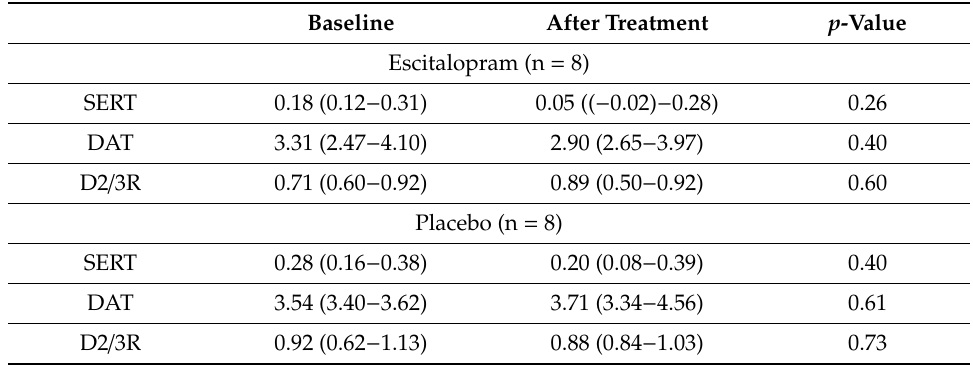
Table 2. Comparison of SPECT Measures (BP ND ) between Pre- and